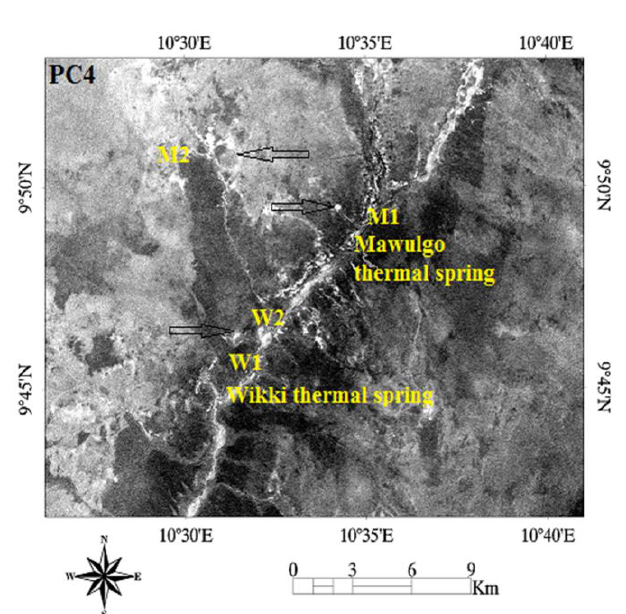
Figure 3. PC4 showing bright pixels as possible alteration zones due to hydroxyl-bearing